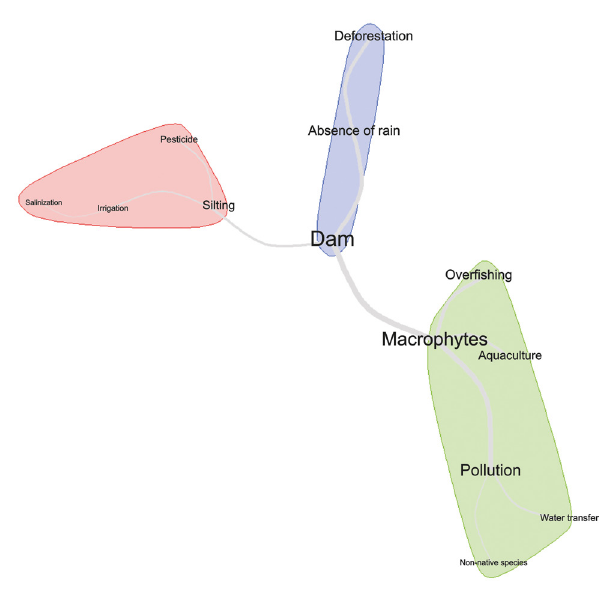
FIGURE 5 | Maximum Similitude Tree showing the expression and relationship of impacts over fisheries in the four areas sampled on the Sub-Middle and on Lower São Francisco, based on fishers’ testimonies (n =